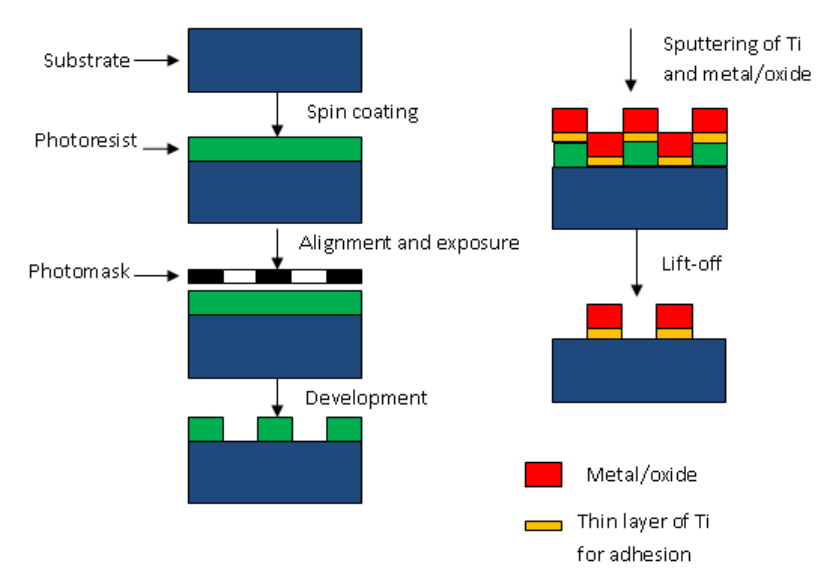
Figure 2. Schematic diagrams of the thin film microfabrication processes, a total of three masked layers processing.